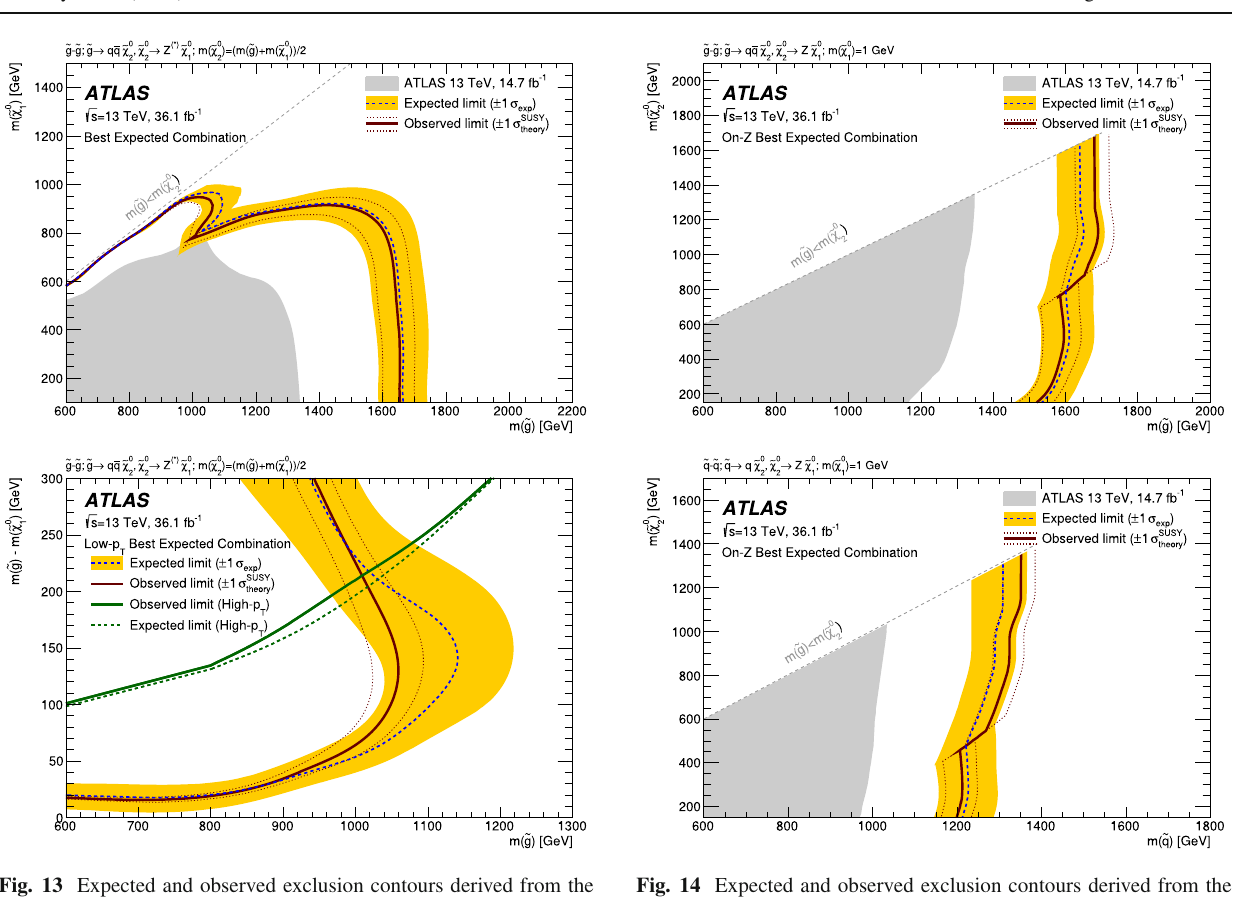
Fig. 13 Expected and observed exclusion contours derived from the Fig. 14 Expected and observed exclusion contours derived from the combinationoftheresultsinthehigh- p T andlow- p T edgeSRsbasedon best-expected-sensitivity combination of results in the on- Z m (cid:4)(cid:4) win- the best-expected sensitivity (top) and zoomed-in view for the low- p T dows of SR-medium and SR-high for the (top) ˜ g − ˜ χ 0 on-shell grid and 2 only(bottom)forthe Z ( ∗ ) model.Thedashedlineindicatestheexpected (bottom) ˜ q − ˜ χ 0 on-shell grid. The dashed line indicates the expected 2 limitsat95%CLandthesurroundingbandshowsthe1 σ variationofthe limitsat95%CLandthesurroundingbandshowsthe1 σ variationofthe expected limit as a consequence of the uncertainties in the background expected limit as a consequence of the uncertainties in the background prediction and the experimental uncertainties in the signal ( ± 1 σ exp ). prediction and the experimental uncertainties in the signal ( ± 1 σ exp ). The dotted lines surrounding the observed limit contours indicate the The dotted lines surrounding the observed limit contours indicate the variation resulting from changing the signal cross-section within its variation resulting from changing the signal cross-section within its uncertainty ( ± 1 σ SUSY ). The shaded area on the upper plot indicates uncertainty ( ± 1 σ SUSY ). The shaded area indicates the observed limit theory theory the observed limit on this model from Ref. [15]. In the lower plot the on this model from Ref. observed and expected contours derived from the high- p T SRs alone are overlaid, illustrating the added sensitivity from the low- p T SRs. Small differences in the contours in the compressed region are due to differences in interpolation between the top and bottom plot